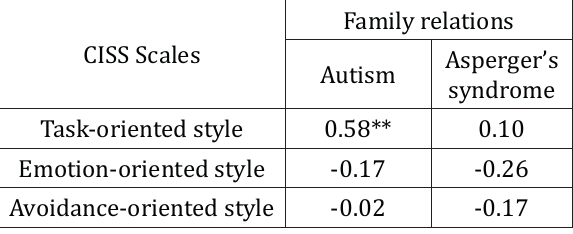
Table 4. Correlation coefficients calculated between the assessment of family relations and stress-coping styles (CISS) in the group of mothers of children with autism and Asperger's syndrome